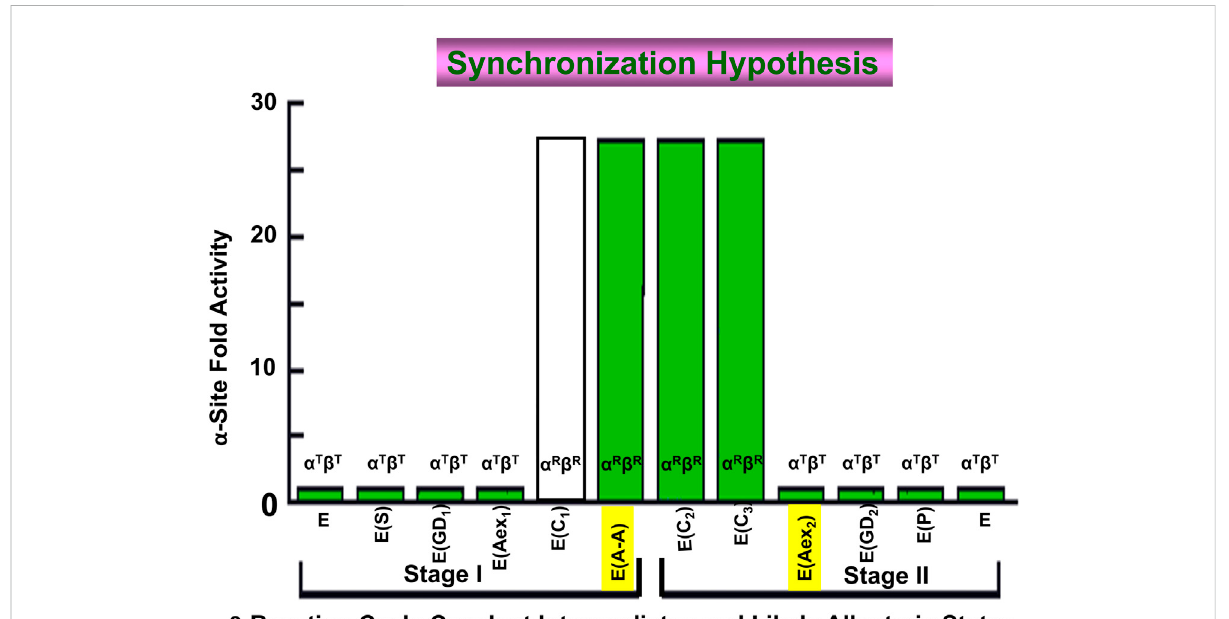
FIGURE 13 Graph depicting the dependence of the steady-state rate of the α -reaction (Y axis) on the covalent state of the β -site (X-axis). When E(Aex 1 ) is converted toE(A-A) the α -siteisactivated > 28-fold (BrzovicP. S.etal.,1992).The α -site isswitched offagain whenE(C 3 )isconverted toE(Aex 2 ).This switchingonandoffensuresthatthecyclesofthe α -and β -reactionsaresynchronizedduringthesynthesisofL-Trp.BecausetheL-Sercarbanionis a fl eetingspeciesandthereisnogoodanalogueforE(C 1 )itisnotknownwhethertheactivityswitchoccurswhenE(Aex 1 )isconvertedtoE(C 1 )or whenE(C 1 )isconvertedto E(A-A).However,theexperiments ofLejaetal. (1995)are consistent withactivation triggered bytheconversion ofE(Aex 1 ) to E(C 1 ). Figure redrawn from Brzovic P. S. et al.